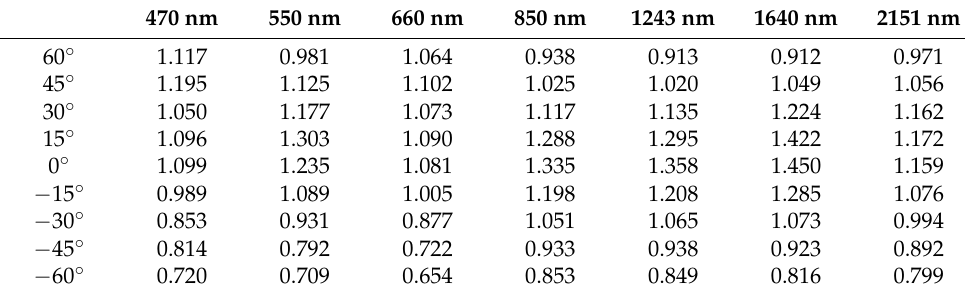
Table 4. Broadband albedo conversion coefficients and standard error